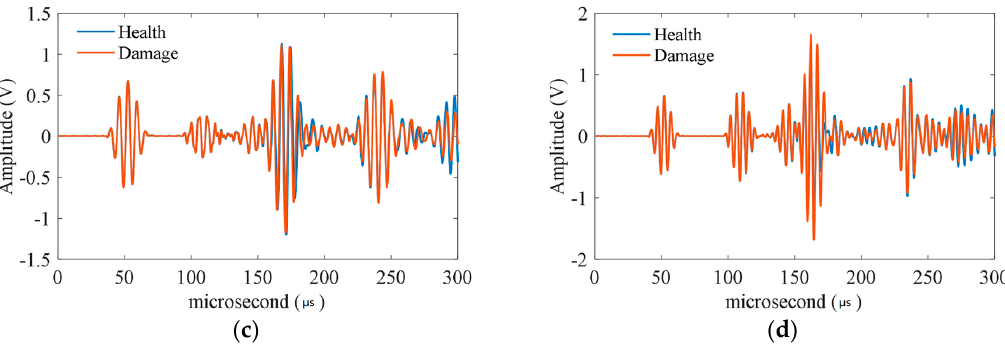
Figure 9. The different frequencies of the Lamb wave in a specific path based on hole-edge corrosion damage. ( a ) 50 kHz; ( b ) 100 kHz; ( c ) 150 kHz; and ( d ) 200 kHz.